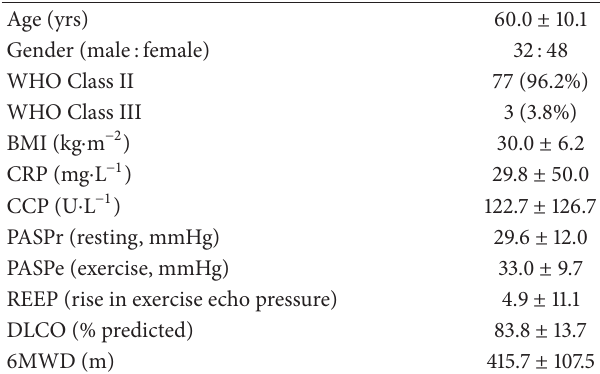
Table 1: Patient characteristics ( 𝑛 = 80